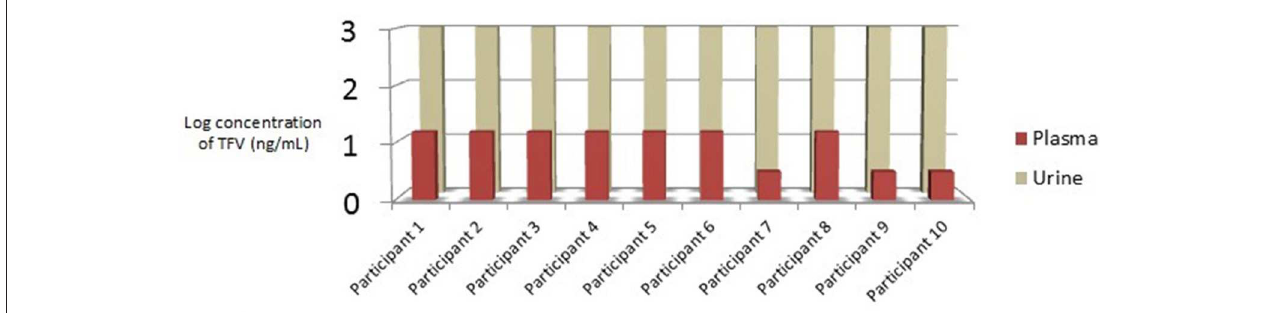
FIGURE 1 | Cohort 1: Relationship between urine and plasma TFV concentrations in PLWH taking daily TAF. TFV, tenofovir; PLWH, Participants Living with HIV; TAF, tenofovir alafenamide; ng/mL, nanograms per millimeter.